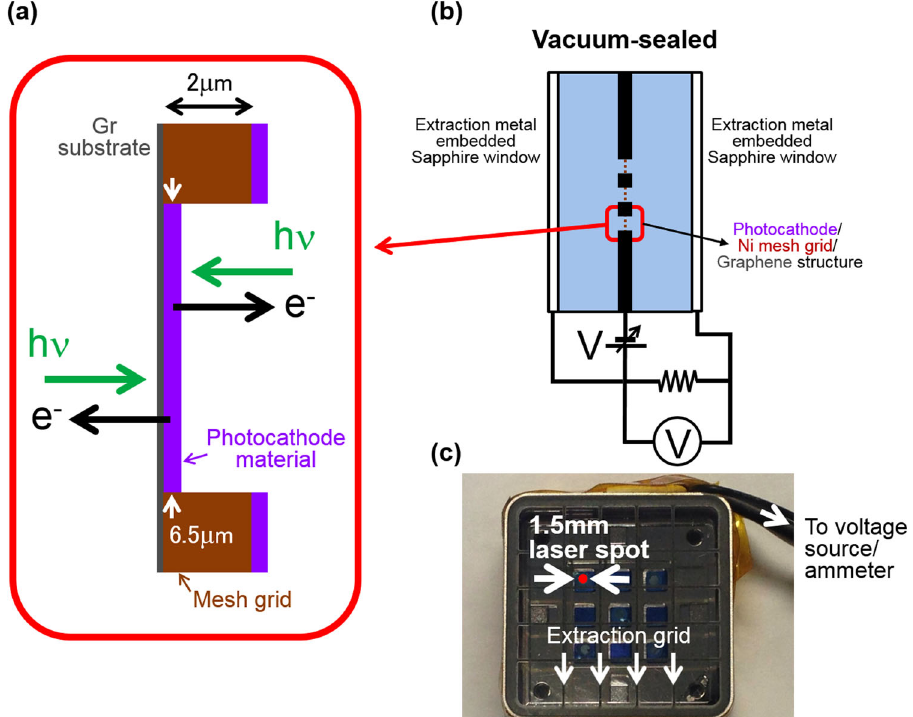
Fig. 1 a Concept of graphene substrate PC. b Schematic of experimental setup. c Photograph of graphene substrate PCs sealed in a vacuum tube. Red circle indicates an optical spot size used for the